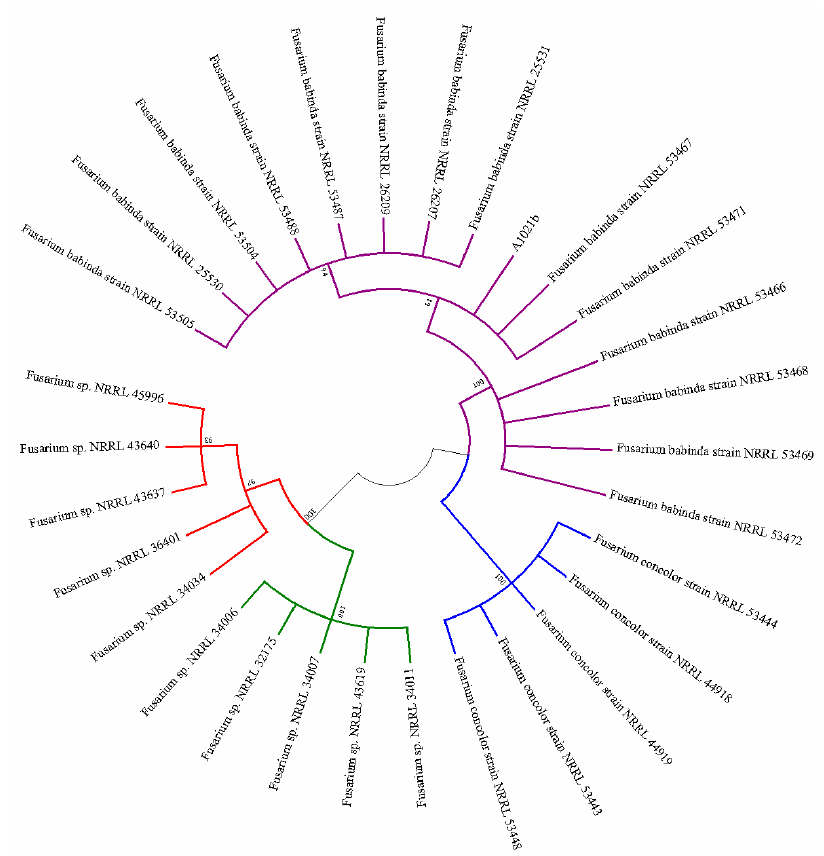
Figure 4. Maximum likelihood tree inferred from TEF1. Phylogenetic analysis including A1021B, strains of FIESC, F. babinda and F. concolor inferred using the maximum likelihood method (MEGA7). The bootstrap consensus tree inferred from 1000 replicates is taken to represent the evolutionary history of the taxa analyzed.